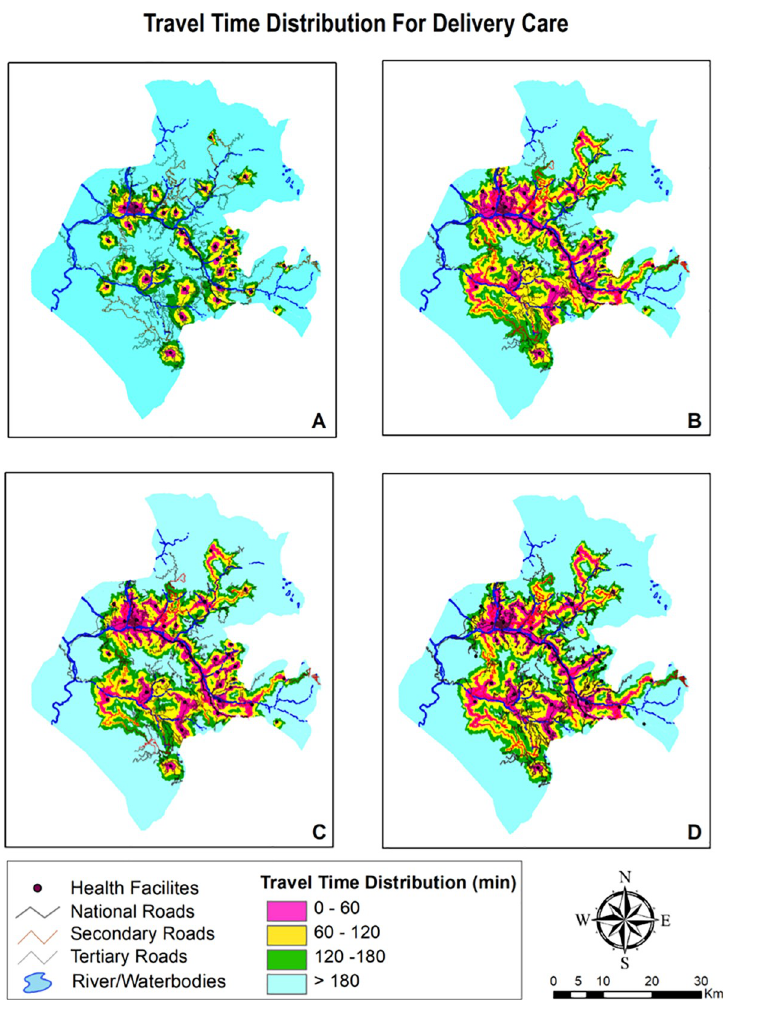
Fig 5. Mapping travel time grid for delivery